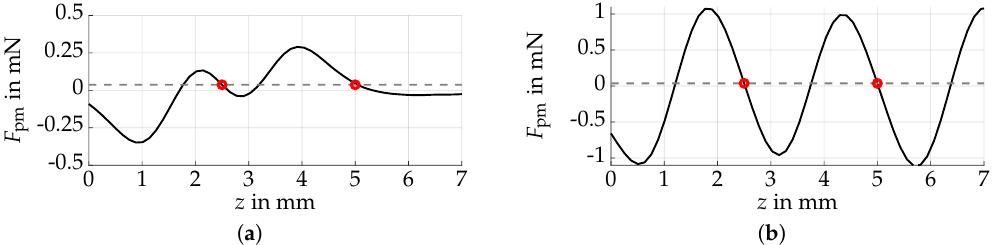
Figure 4. Simulated magnetic force characteristic F pm of the superimposed magnetic fields. The intersections with the gravitational force (dashed, gray) correspond to the predefined, stable equilibria and are marked by red circles. ( a ) Setup 1: two equilibria are generated by superimposing two magnetic fields. ( b ) Setup 2: the identical resting positions are achieved by three ring magnets, but the choice of magnet parameters is more flexible. The third equilibrium of Setup 2, which is above 7mm, is unintended and therefore not